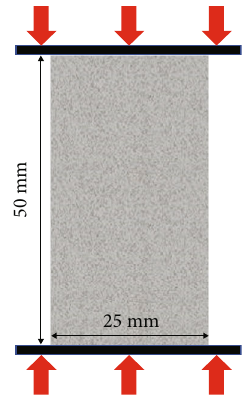
Figure 3: Intact numerical model generated in PFC 2D in this